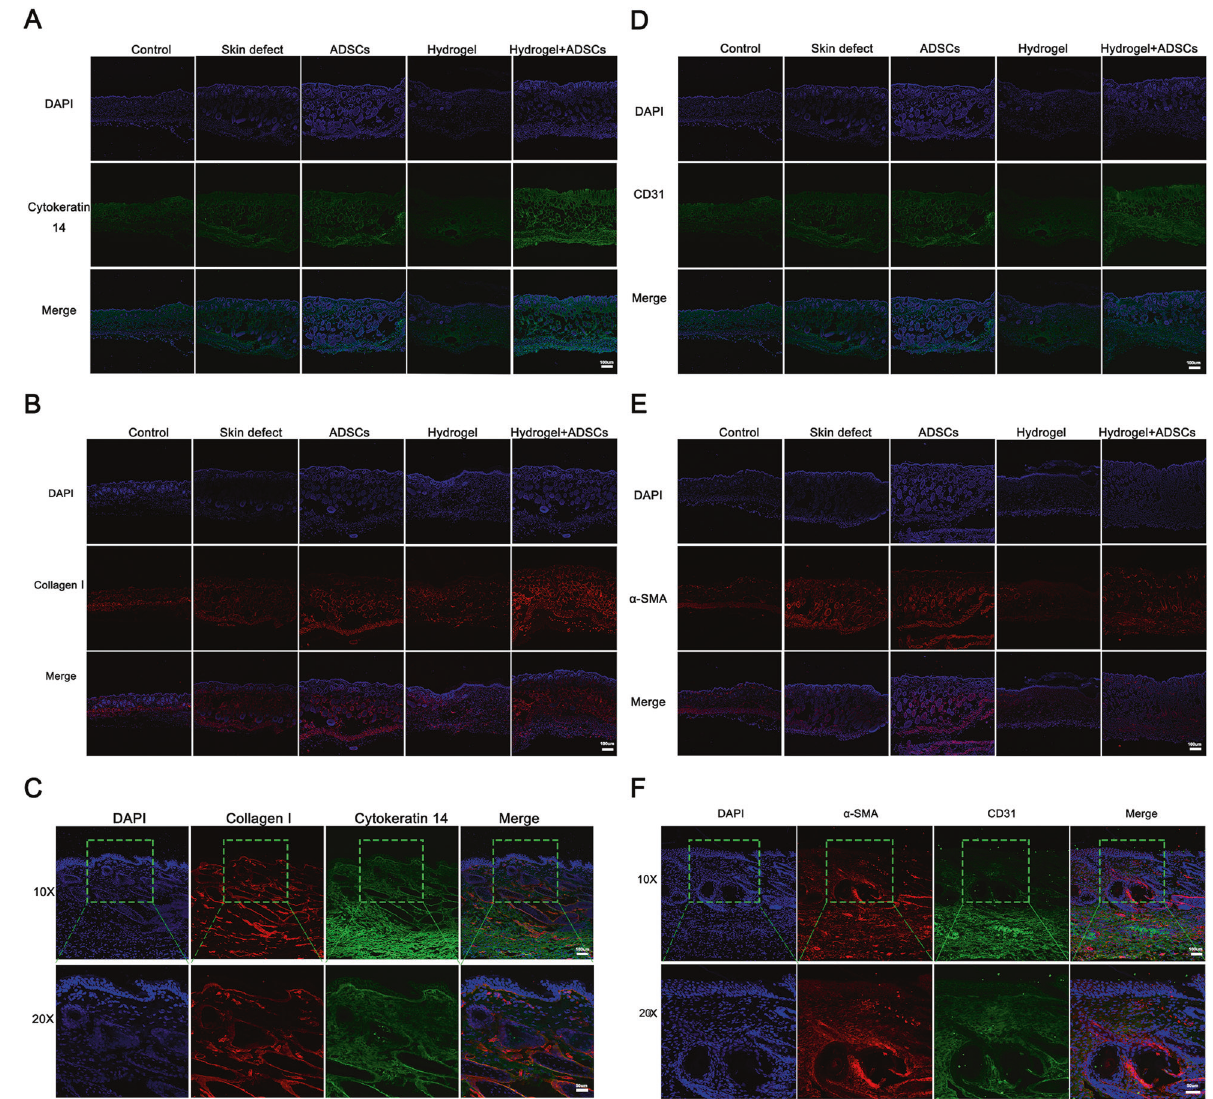
Fig. 5 DA-MeHA hydrogel-encapsulated ADSCs promoted epidermal regeneration and dermal collagen formation and accelerated neovascularization. A Cytokeratin 14 (CK14) is a surface marker of the epidermis the is used to evaluate skin defect re-epithelialization. IF staining showed higher CK14 expression in the hydrogel + ADSCs group than in the other groups. B Considering the migration of fi broblasts to the wound area, the collagen I level was measured to evaluate the therapeutic effects of the different treatments consisting of the DA- MeHA hydrogel and ADSCs. IF staining showed higher collagen I expression in the hydrogel + ADSCs group than in the other groups. C Images of IF staining from the hydrogel + ADSCs group showed that CK14 and collagen I were coexpressed in the skin. D CD31 is a surface marker of vascular endothelial cells. IF staining showed higher CD31 expression in the hydrogel + ADSCs group than in the other groups. E α -SMA is a speci fi c marker of myo fi broblasts (MFB) that is used to evaluate skin defect re-epithelialization. IF staining revealed higher α -SMA expression in the hydrogel + ADSCs group than in the other groups. F IF staining of the hydrogel + ADSCs group showed that α -SMA and CD31 were coexpressed in the regenerated skin, indicating that the ADSCs embedded in the DA-MeHA hydrogel retained a good ability to promote angiogenesis, and the effect was better than that of injection of rather than a simple linear pathway [45]. Our results may indicate that Notch signaling increases the differentiation of skin stem cells via a Hes1-independent mechanism. High Notch signaling levels promote the differentiation of epidermal stem cells (EpSCs) into interfollicular lineages [28]. Activation of Notch2 and Notch3 stimulates terminal differentiation, and Jagged1 and Jagged2 also function as terminal differentiation – inducing stimuli [46]. Hence, we hypothesized that the upregulated expression of Notch1 in the hydrogel + ADSCs group contributes to basal cell proliferation and further accelerates epidermal regeneration. In addition, Notch2 and Notch3 cooperate to induce the terminal differentiation of interfollicular epidermal cells.